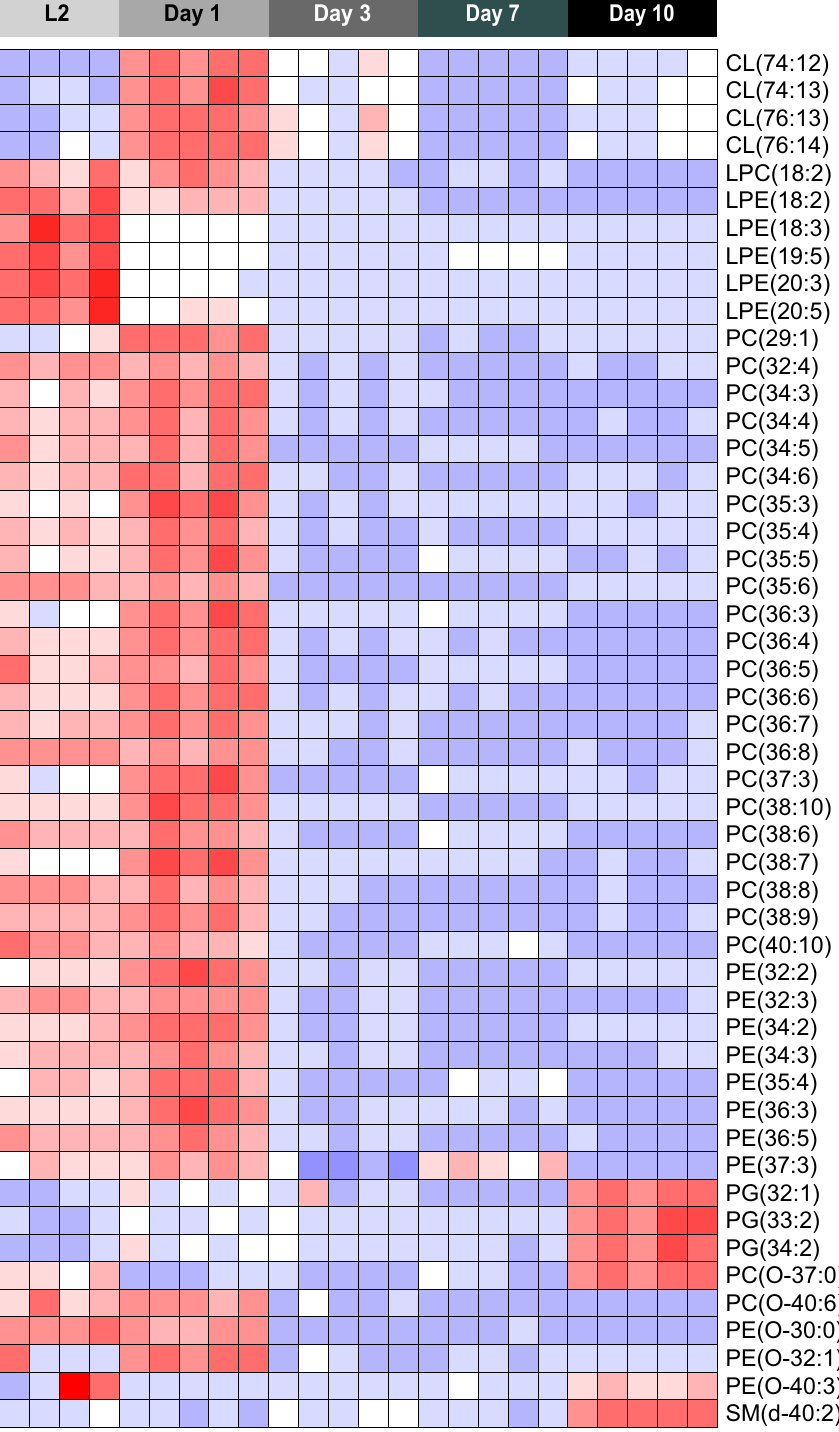
grown at 25 °C 28 . We collected glp-4 ( bn2 ) mutants at larval stage L3, reproductive phases of adulthood on day 1, day 3 and day 5, and elderly stages day 7 and day 9 and measured FAs and AAs. Similar to what we observed in